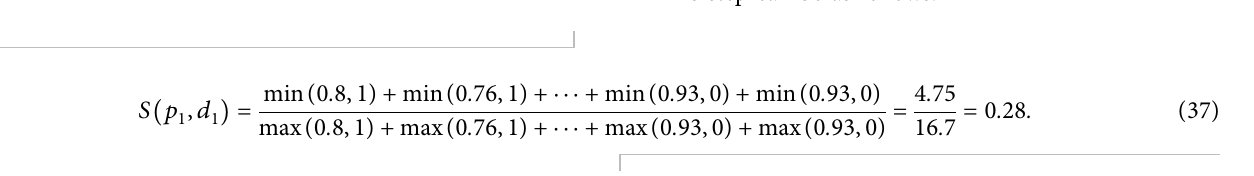
Table 24: Tabular representation of ( F